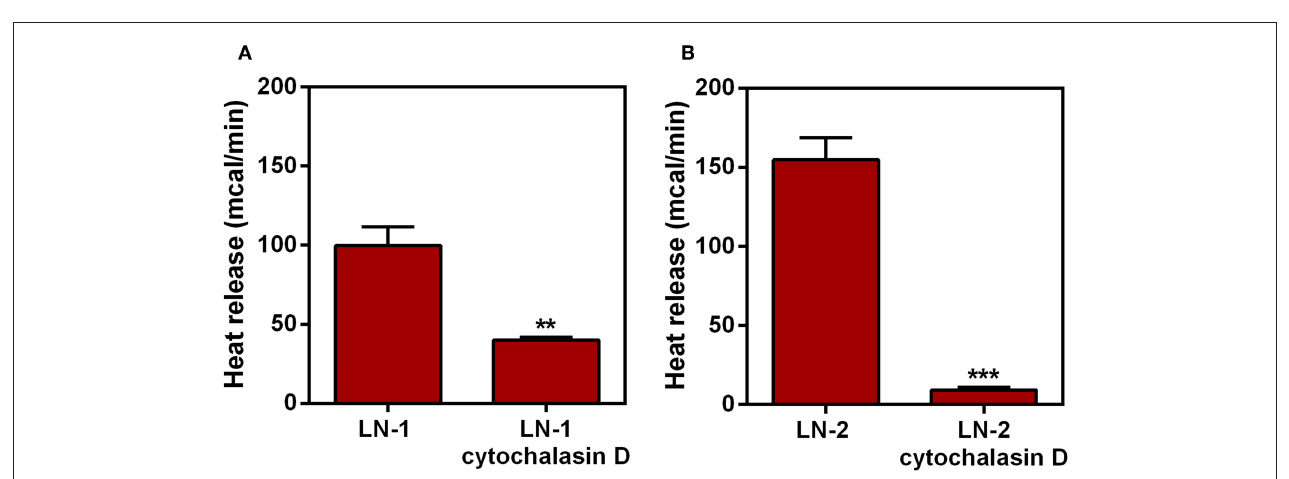
FIGURE 3 | Effect of cytochalasin D on heat release by human oral squamous carcinoma cells LN-1 and LN-2. The bars represent the release of total heat of living cells in 35min of experiment. (A) Heat release by LN-1 cells untreated and treated with cytochalasin D 2 mg/mL; (B) heat release by LN-2 cells untreated and treated with cytochalasin D 2 mg/mL. Values were expressed as mean ± SEM. ** p < 0.01; *** p <